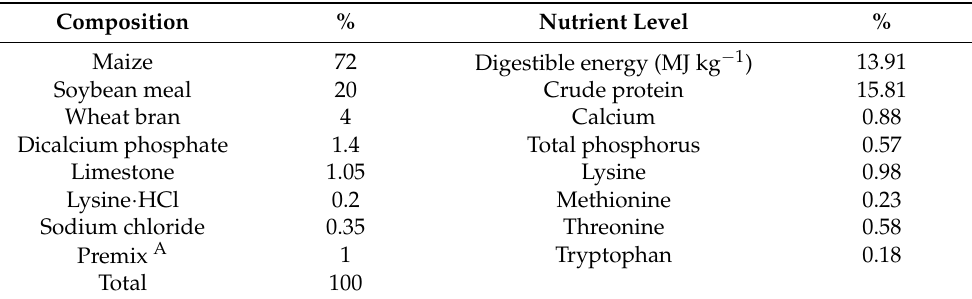
Table 1. Composition and nutrient level of basal